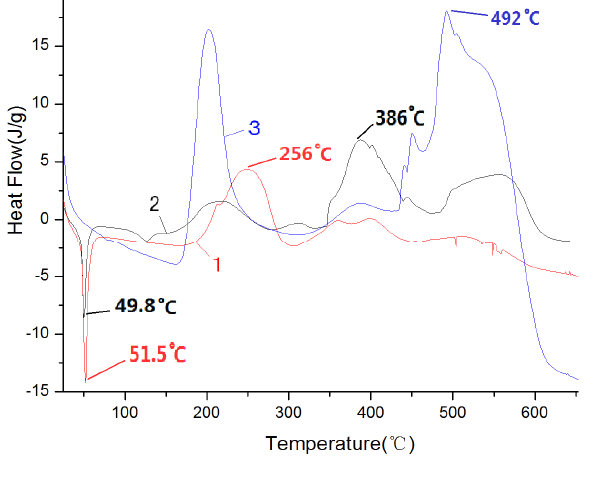
Figure 3. The DSC curves of Paraffin, Pretreated paraffin, and HTPB in O 2 .